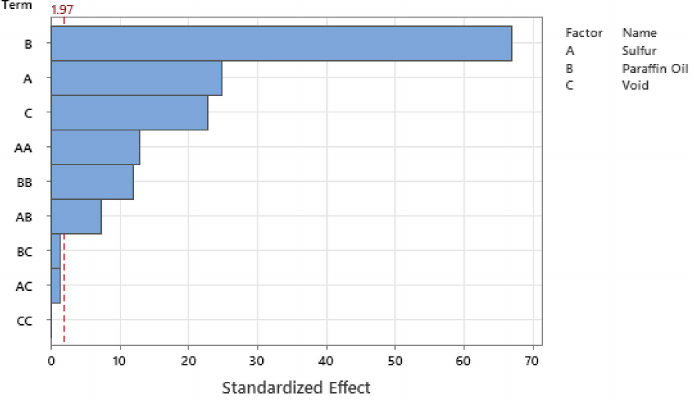
Figure 27. The Pareto Chart of Standardized Effects for durometer reading.